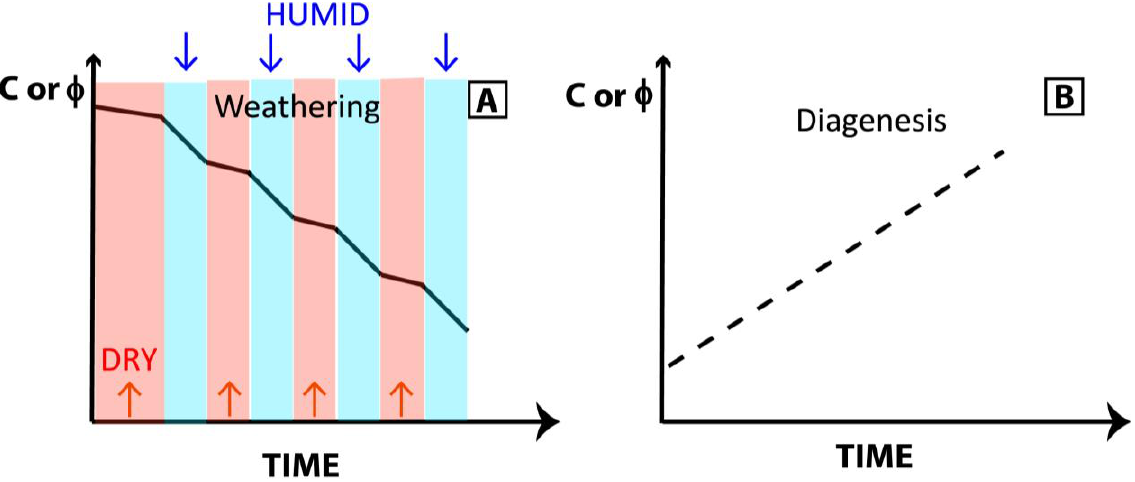
Figure 6. Influence on the mechanical rock properties C and ϕ of ( A ) Weathering ( B ) Diagenesis.